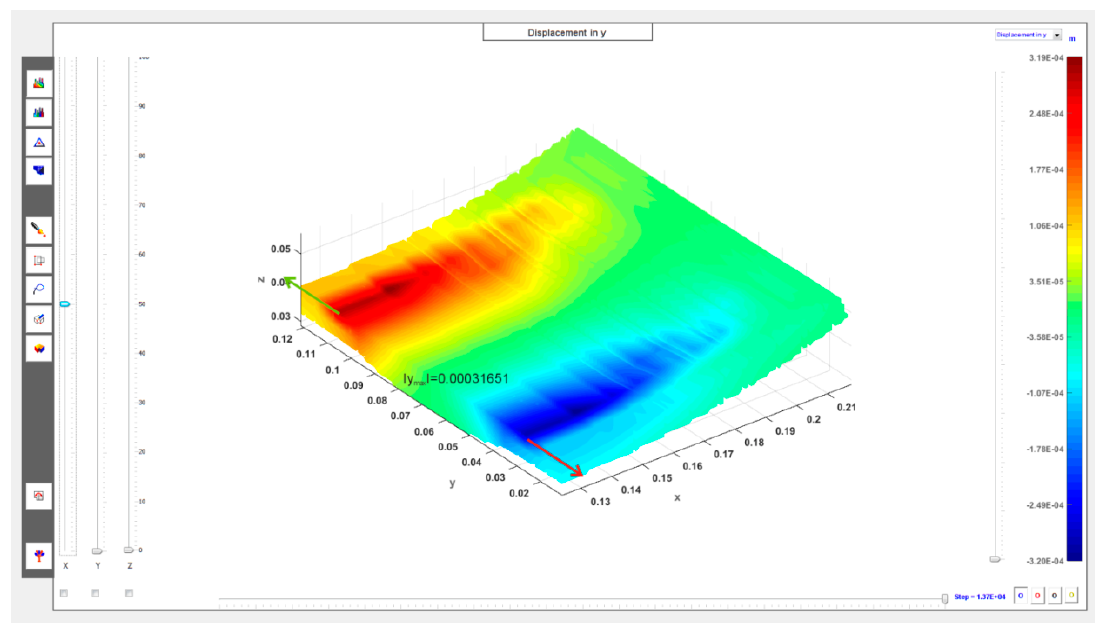
Figure A14. Displacements (in meters, middle section) in sand layer in parallel y direction to roller axis: h = 4.0 mm, p opt = 3.35 bar ( N = 1675 N).